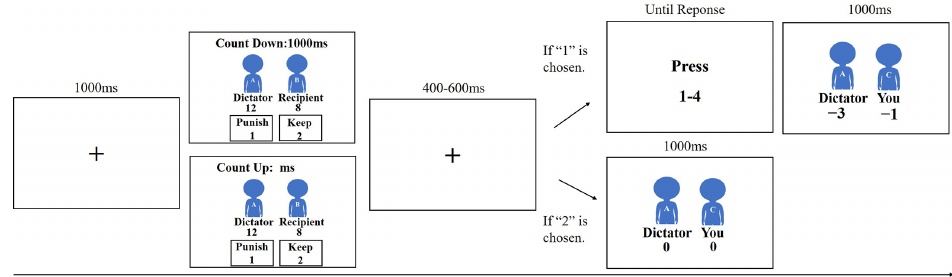
Figure 1. A depiction of the third-party punishment task.